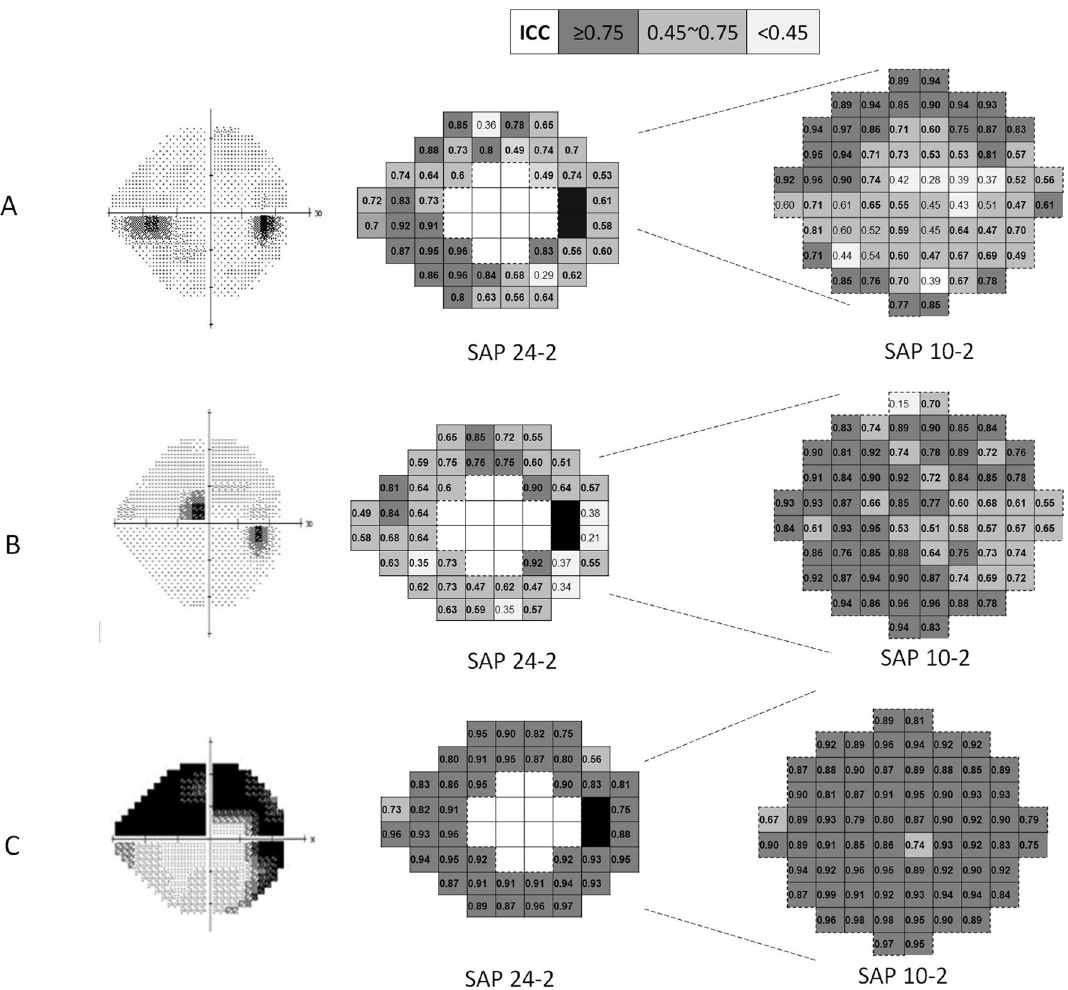
Figure 4. Point-wise ICC between the combined VF test and 24-2 VF test or 10-2 VF test. ( A ) In the peripheral nasal step group, the agreement between the 24-2 VF test and combined VF test was excellent in the scotoma lesion area. ( B ) In the paracentral scotoma group, there was excellent agreement between the combined VF test and the 10-2 VF test. ( C ) In the paracentral and nasal scotoma group, the VF tests revealed excellent agreement existed between them. The figure was prepared using the Excel and PowerPoint program in Microsoft Office 365 (https ://www.offic e.com/, freely available for teachers at qualified academic